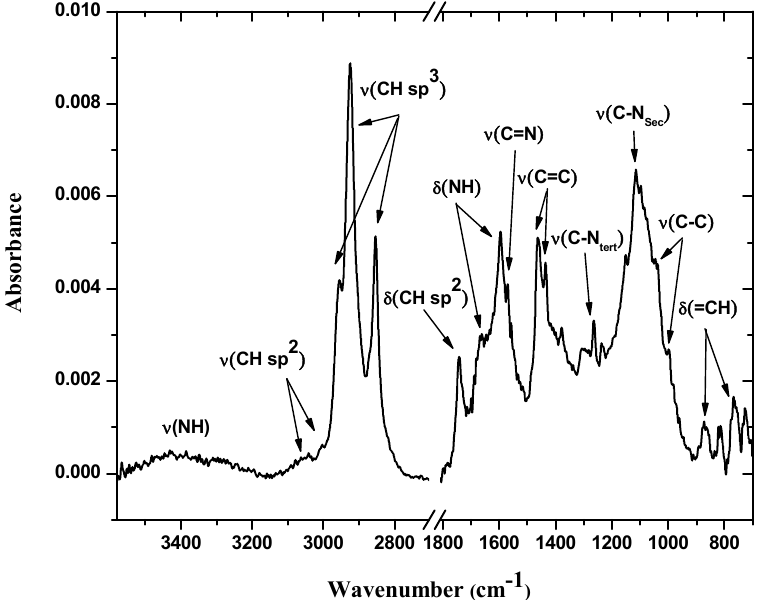
Figure 3. IR-ATR spectra of bis-N-MPyC film surface (from 700 to 1800 and from 2700 to 3600 cm − 1 ).